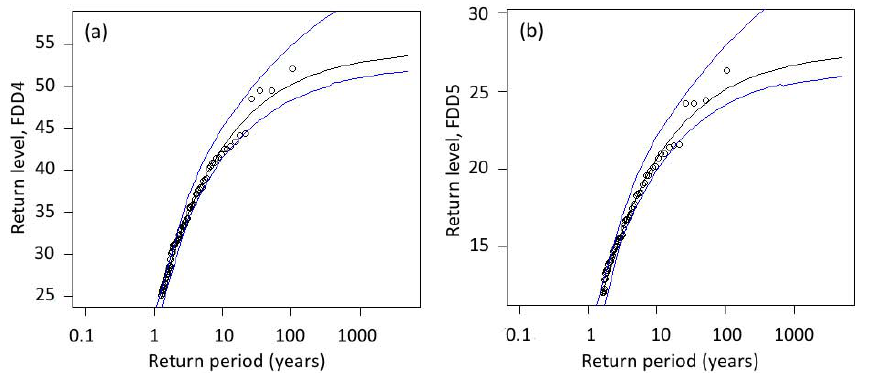
Fig. 8. Return level plots of (a) FDD4 and (b) FDD5 for 1908–2011. Black curve denotes maximum likelihood estimate of return level against different return periods. Blue curves are 95% confidence limits of return levels based on the profile likelihood method. Table 4. Maximum likelihood estimates (MLE) of return levels of FDD4 and FDD5 for 5, 10, 20, 50, 100, 200 and 500-yr return periods based on data from period 1908–2011. Upper and lower confidence intervals (CI), the used data threshold (u) for GPD fitting and the proportion of data exceeding the threshold (Rate) are presented